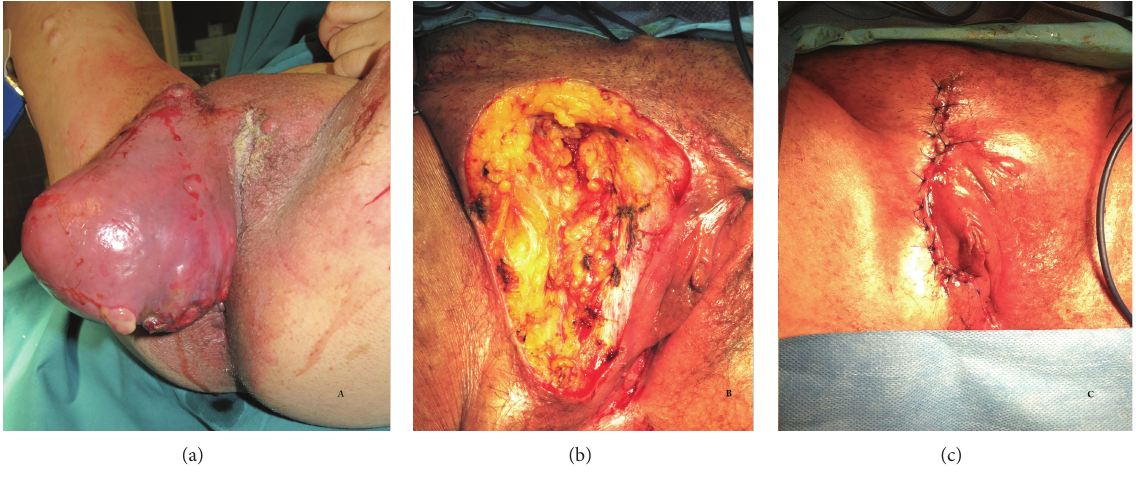
Figure 1: Vulvar